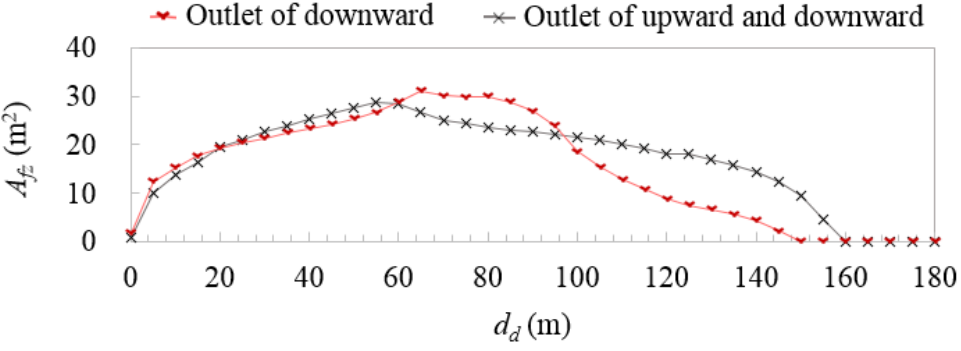
Figure 12. Area of FZ ( A fz ) for the cross section of vertical line at every 5 m drifting distance ( d d ); the scenario of emission from the first vent mast alone at a relative wind speed of 10 m/s is shown.